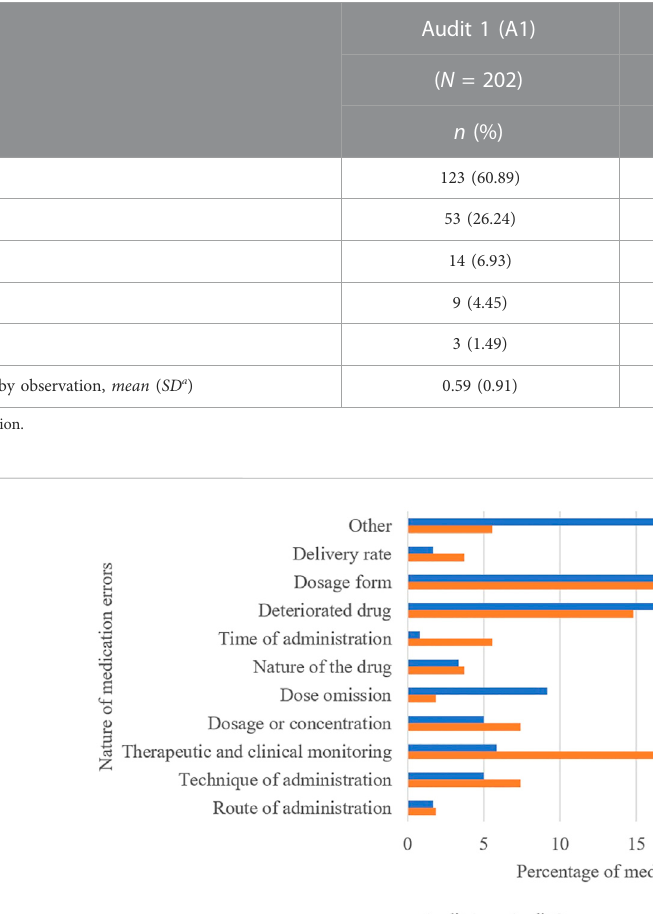
TABLE 3 Number of observations according to the number of ME and number of ME by observation for audits 1 and 2.